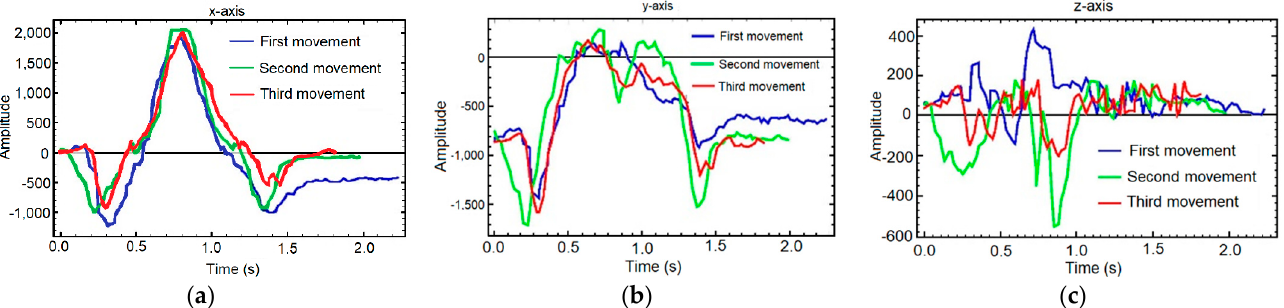
Figure 9. Samples overlapped by axis: ( a ) X -axis, ( b ) Y -axis, ( c ) Z -axis. Each graph shows the comparison between the first movement (blue), the second (green) and the third (red).